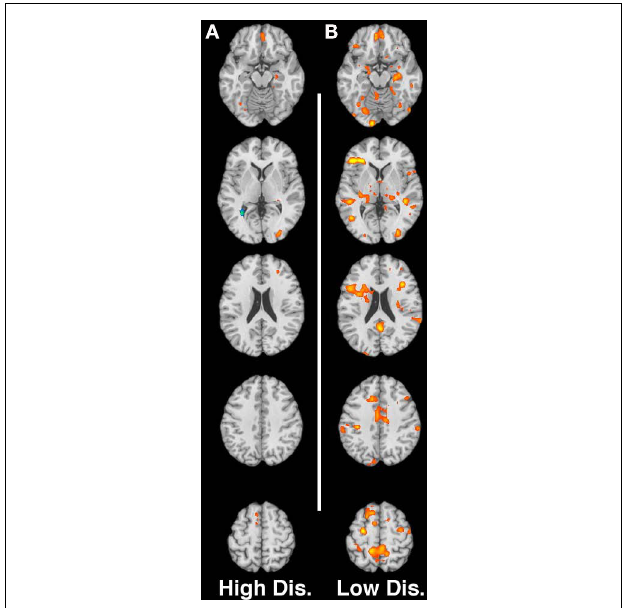
FIGURE 2 | (A,B) Contrast of non-using > substance-using for low-distress and high-distress cries respectively. Slices are at MNI z -coordinate locations − 16, + 2, + 20, + 38, and + 56mm.